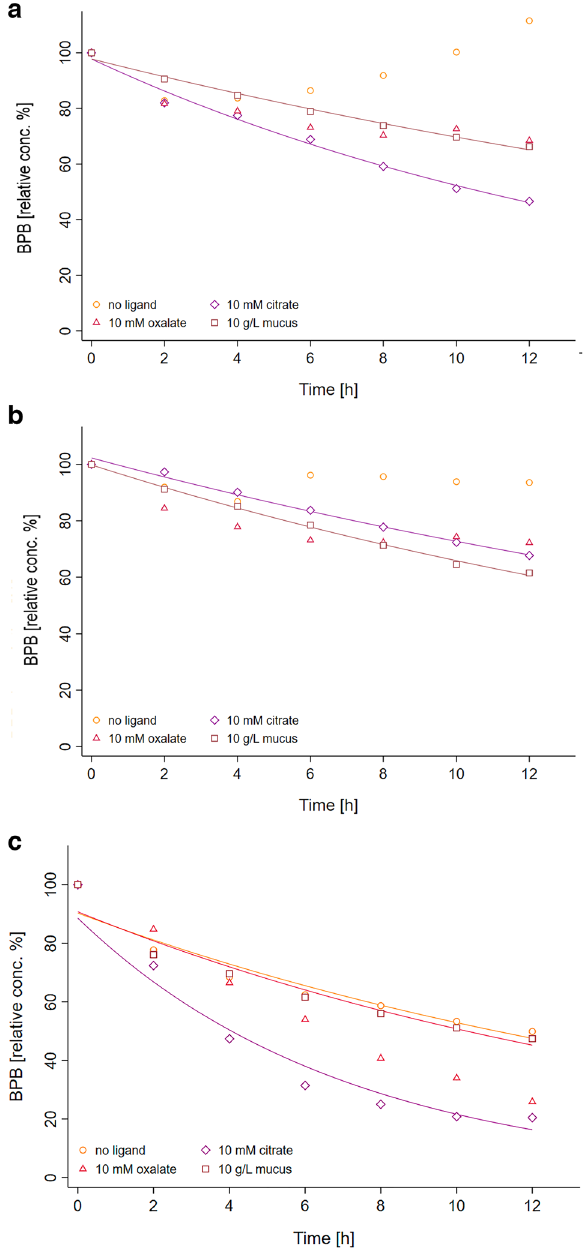
Figure 4. BPB degradation induced by the addition of H 2 O 2 (5 mM) calculated from spectrophotometric kinetic data for Fe(II) ( a ), Fe(III) ( b ) and Fe 3 O 4 NP ( c ). Each dot results from the correction of experimental absorbance values with the corresponding blanks (no BPB; no H 2 O 2 ) and after conversion into BPB